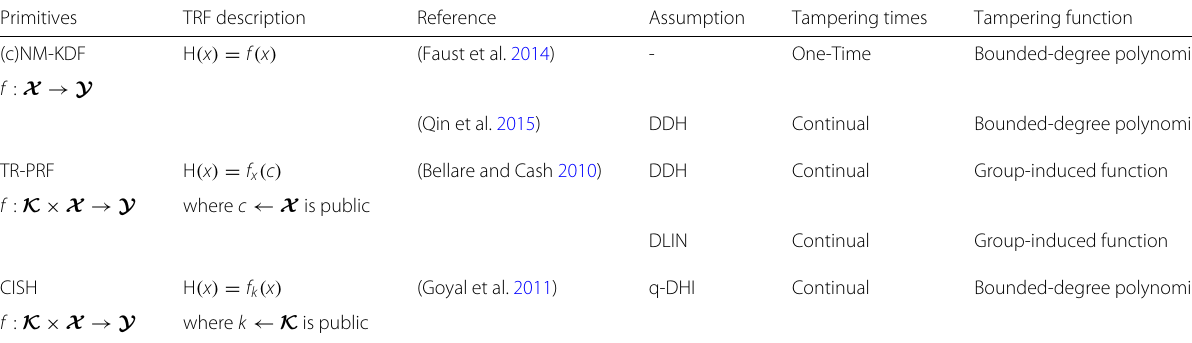
Table 2 A comparison of TRF based on different primitives